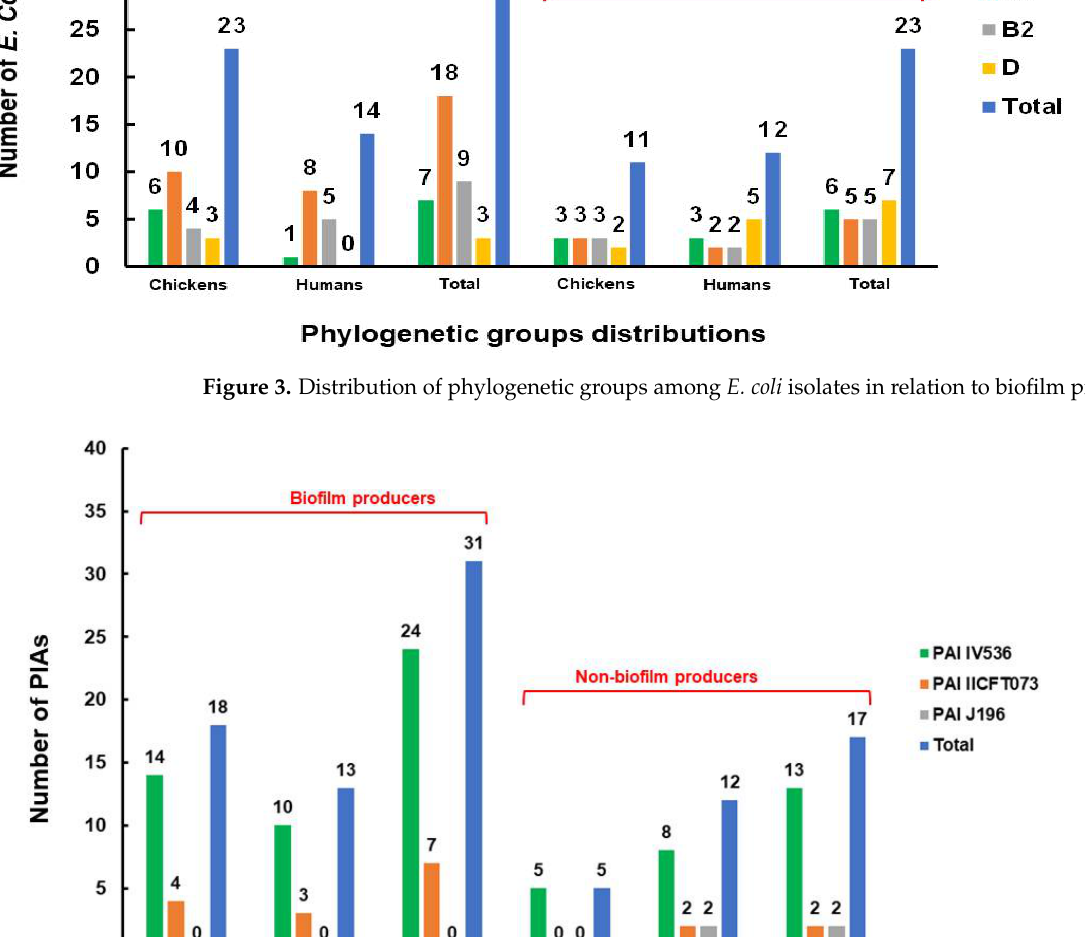
Figure 4. Distribution of pathogenicity islands (PAIs) among E. coli isolates in relation to biofilm 208 production.